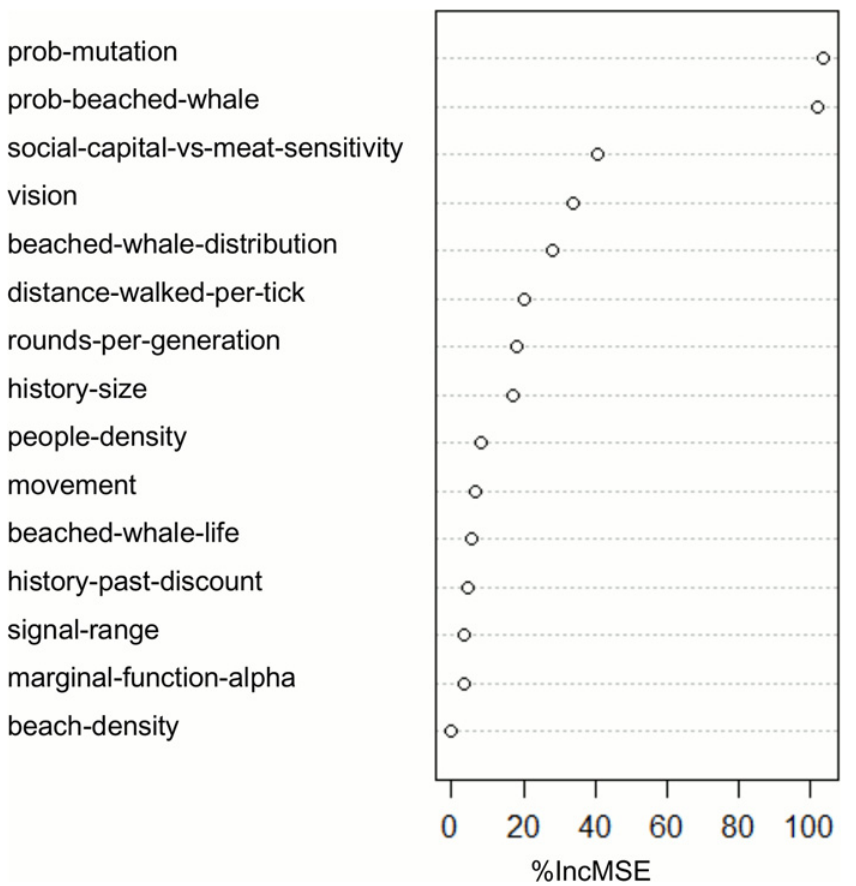
Fig 5. Parameter importance. A random forest with mtry = 18/3 (where 18 is the number of parameters) and ntree = 300 (for this value the MSE is stabilised) has been implemented. The permutation-based MSE reduction is used as the criterion of importance to rank the model parameters. By randomly permuting predictors (i.e. parameters) and observing how much the MSE grows, the more important a predictor, the more increase in the MSE is